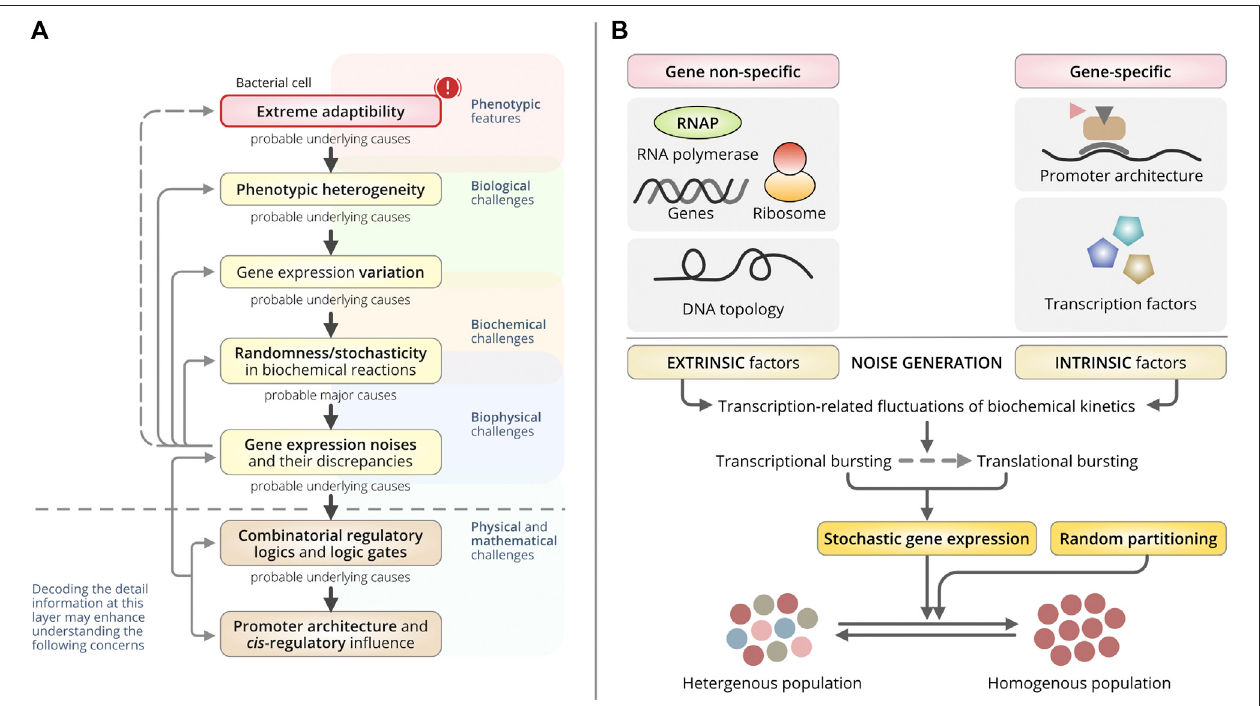
FIGURE 1 | Overall concept and origin of gene expression noise. (A) A schematic dogma of the generation of bacterial phenotypic heterogeneity. This schematic represents the central direction and the overall realizations by the authors discussed in this review paper. Biological challenges are greatly masked by the multiplexed layers backed by biological origin, biophysical origin, and deep-rooted physical and mathematical origin. Similarly, bacterial heterogeneity and random yet extreme adaptability in a wide range of detrimental circumstances have been a great challenge. These challenges are merely not to be addressed by biological knowledge only. The underlying mechanisms, quantitative foundations, structural and functional aspects including their interdependencies to each other are inevitably pivotal to tracebackthoseintricatedchallenges.Inthisreview,theauthorshaveidenti fi edtherelationalmodelofthephenomenonfromtheverymolecularleveltothephenotypes. (Toptobottomdirection):Afewchallengeswithbacterialextremeadaptabilityandpromptphenotypicswitchingcanbeexplainedwiththebasisofphenotypicheterogeneity. Torevealthebasisofphenotypicheterogeneity,theunderlyingbiologicalchallenges,thatisthevariationsingene-expressionsareessentialtounderstand.And,thedifferential gene-expression noise, intrinsic and extrinsic transcriptional noise, and their discrepancies may support the explanation of the wide extent of gene-expression variation. It relies mostly on the biophysical basis of gene expression. Subsequently, a question remains important that what drives or controls those noises? The most probable hints havebeenestablishedwiththearisingscienti fi csupportsenrichingtheunderlyingcausesasthedifferentregulatorylogicsanddifferentcombinationsofthelogicgatesbeing constructedbythedifferentregulators.Finally,thepromoterarchitectureandthesuccessiveinteractionofdifferent trans- regulatoryelementshavebeenidenti fi edtoin fl uence thecombinatorialselectionofdifferentlogicgatesthattriggersthevariablegene-expressionnoise(bottomtotop),thusthevariationingene-expressionsandcausingbacterial phenotypic heterogeneity. (B) Schematic ofthe originofgene-expression noise that dictates the cell-to-cellvariationin the clonalpopulation ofbacteria. Bacterial cell-to-cell variability in the clonal population used to be mediated through stochastic gene expressions or fl uctuations in random partitioning during cell division. Stochastic gene expressionismajorlyin fl uencedbygene-independentextrinsicfactorsandgene-speci fi corgene-dependentintrinsicfactorsthroughgene-expressionrelated fl uctuationsin biochemical reaction kinetics. It gets manifested in both transcriptional and translational